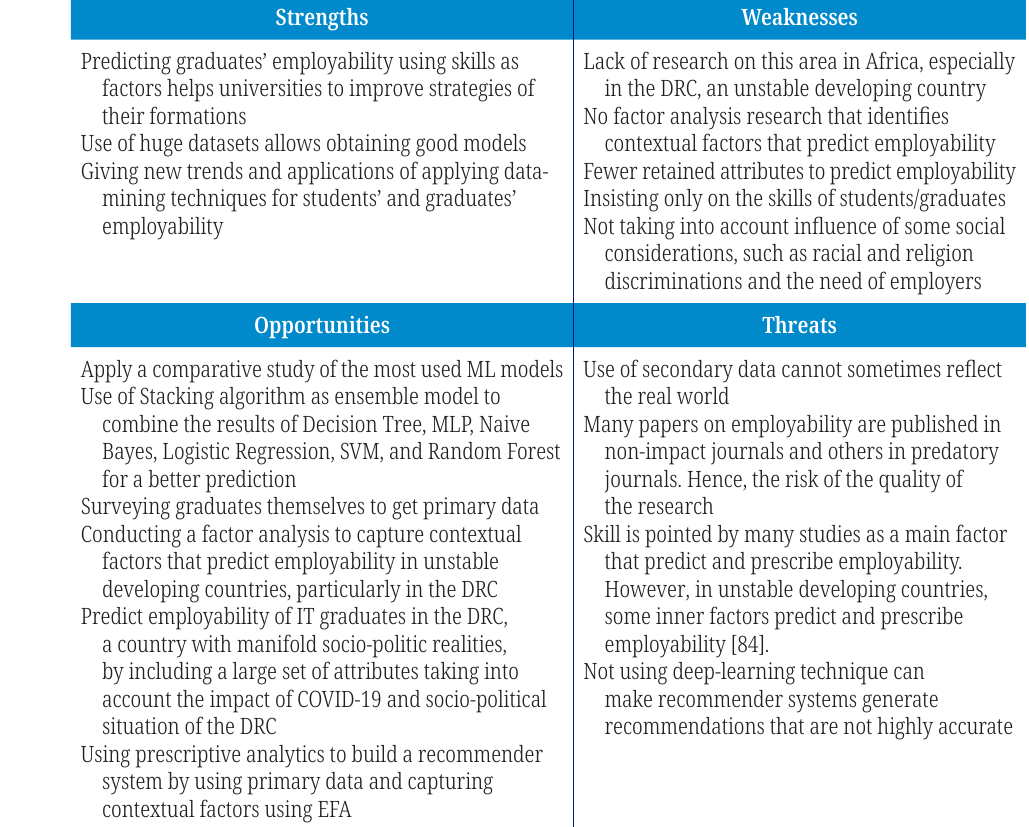
Table 9. SWOT of application of data-mining techniques on employability research